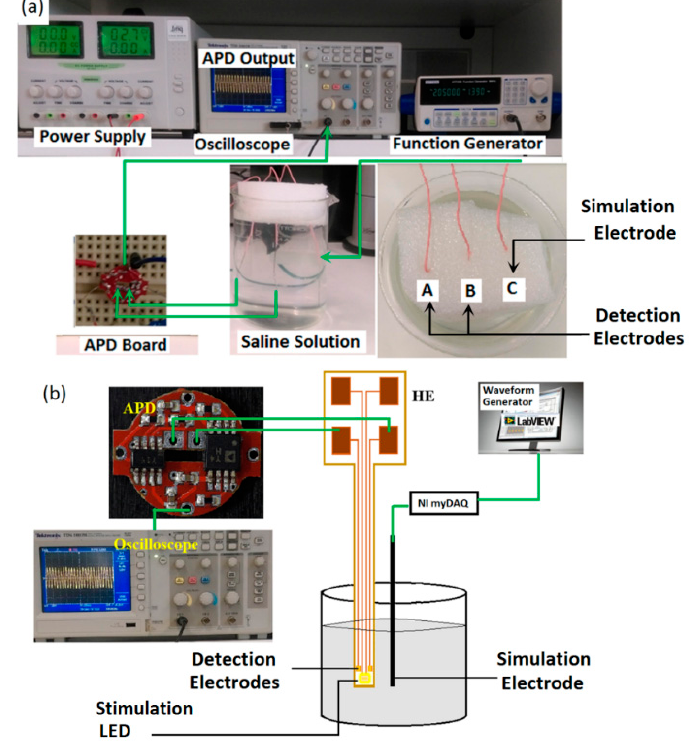
Figure 11. In vitro test setup for the APD evaluation. ( a ) With sine signal. ( b ) With synthetic neural signal.